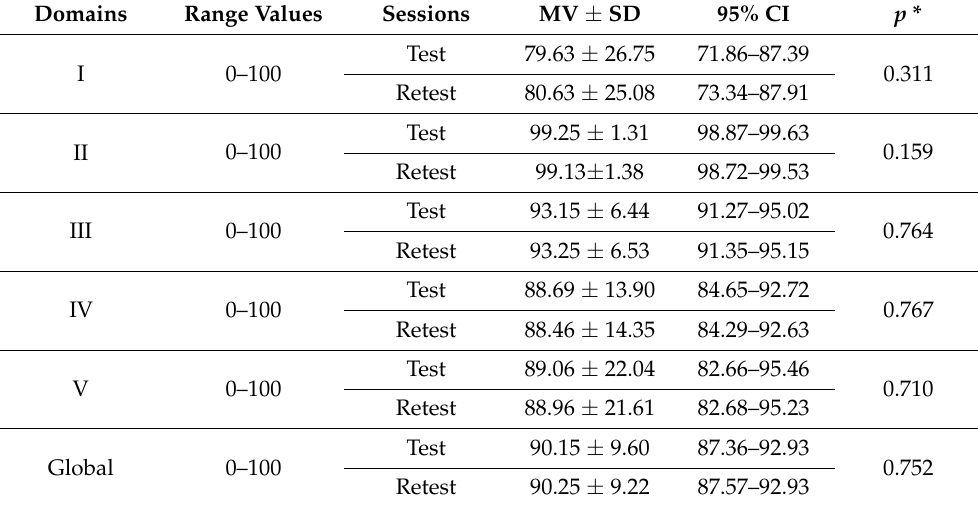
Table 1. Serbian version of PODCI raw scores for the test and retest. Domains